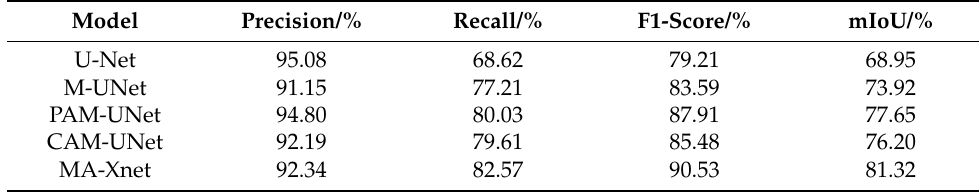
Table 3. Ablation experimental